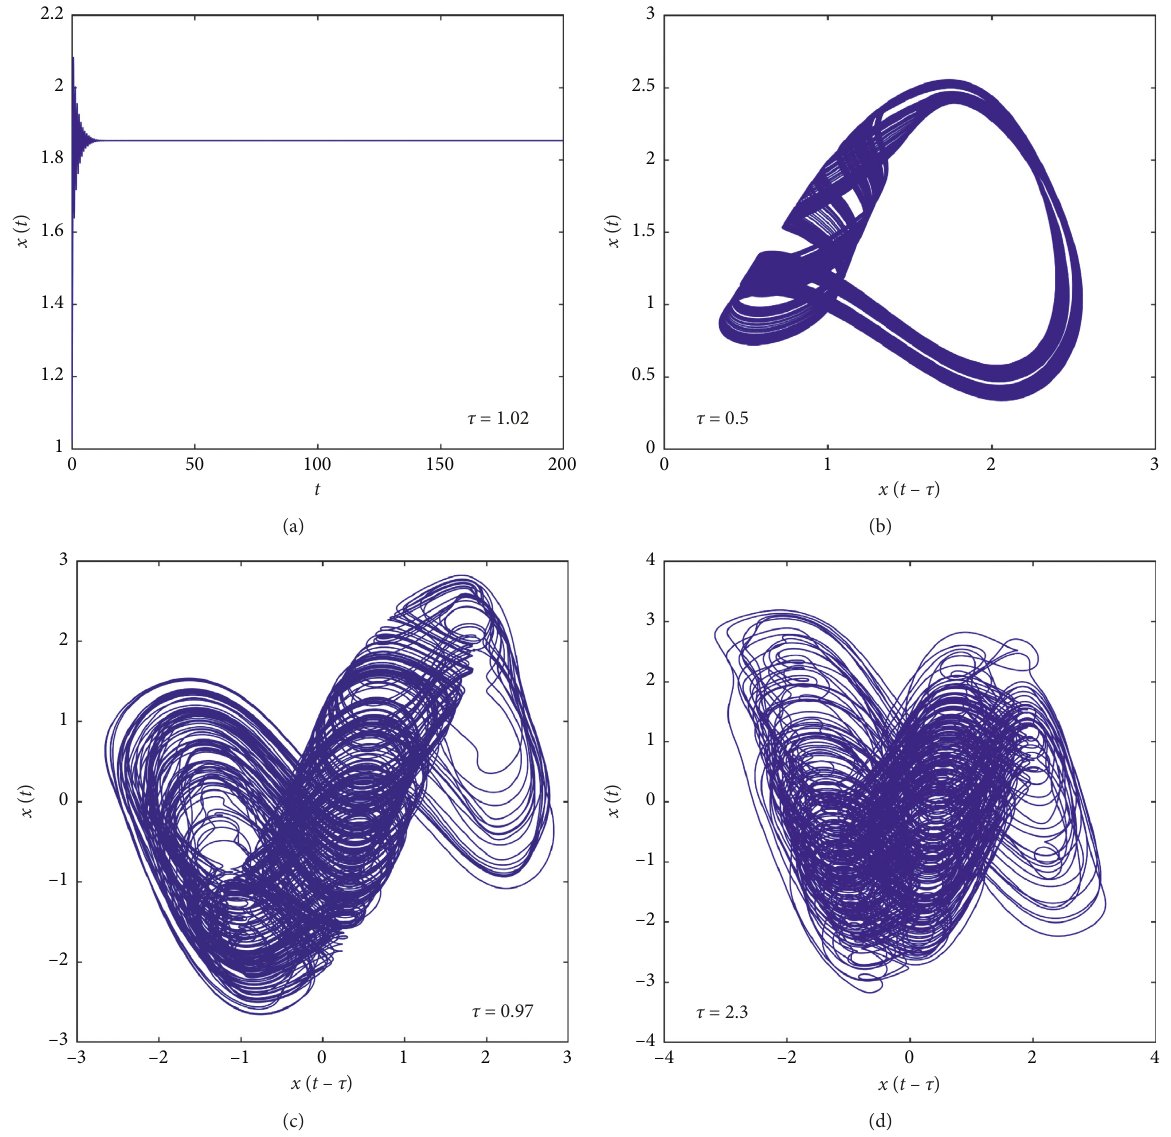
Figure 7: The initial condition is ϕ ( t ) � 1 for t ∈ [− τ , 0 ] throughout the investigation. Parameters a � 1 and b � 4. (a) Period limit cycle for τ � 0 . 2, (b and c) chaos attractors for τ � 0 . 5 and τ � 0 . 97, and (d) multiscroll hyperchaotic attractors for τ � 2 .